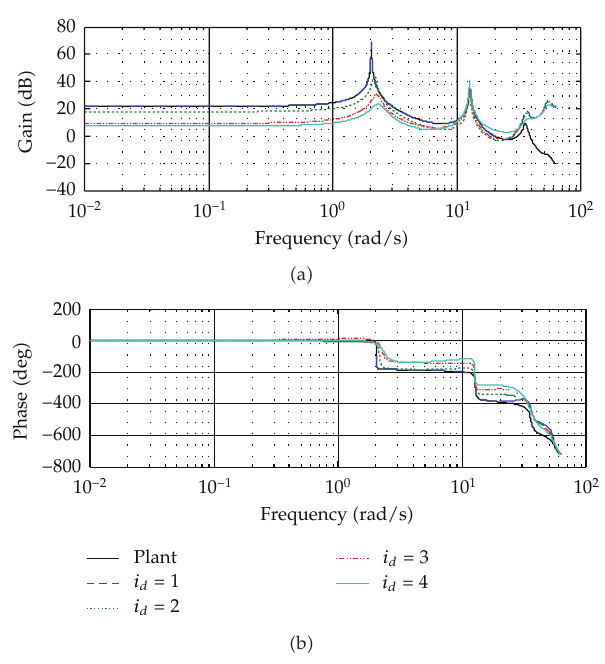
Figure 3: Bode plots of the true plant P (cid:4) z (cid:5) and its models P i d